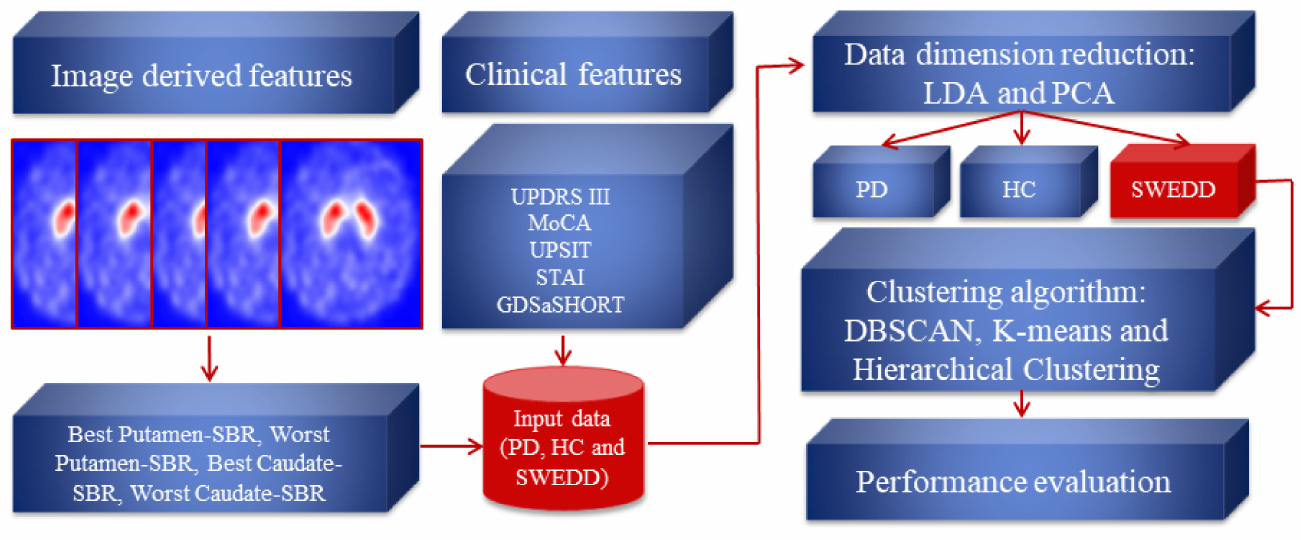
Figure 1. The structure diagram of the proposed